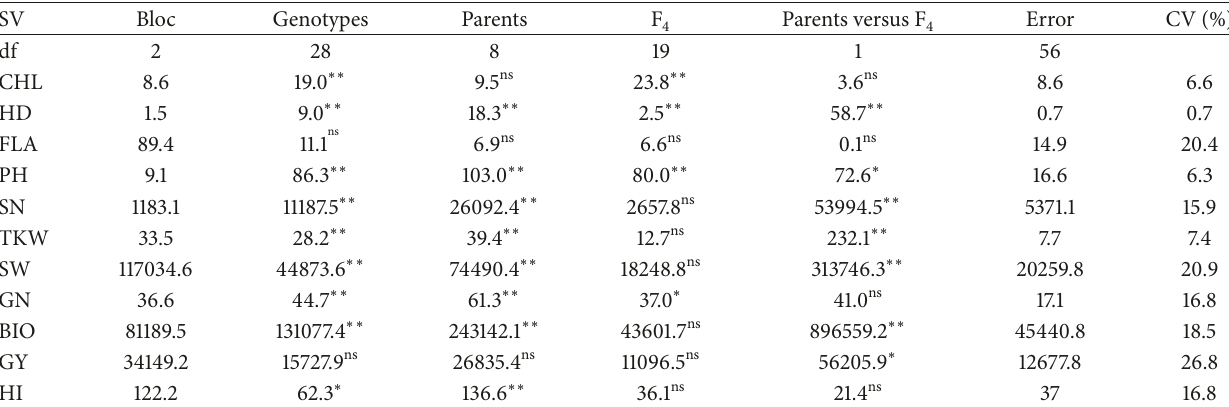
Table 2: Analysis of variance of different bread wheat traits studied.